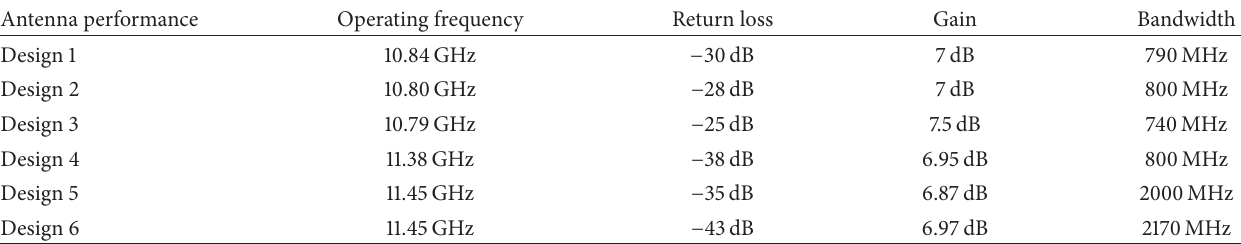
Table 3: Return loss, gain, and bandwidth of all the design analysed in this